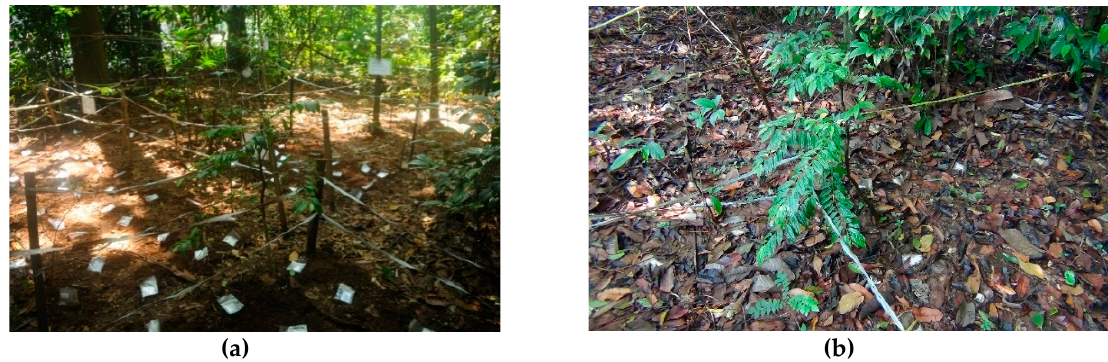
Figure 2. Subterranean termite field test in the beginning (a) and at the end (b) of 1-year of exposure.